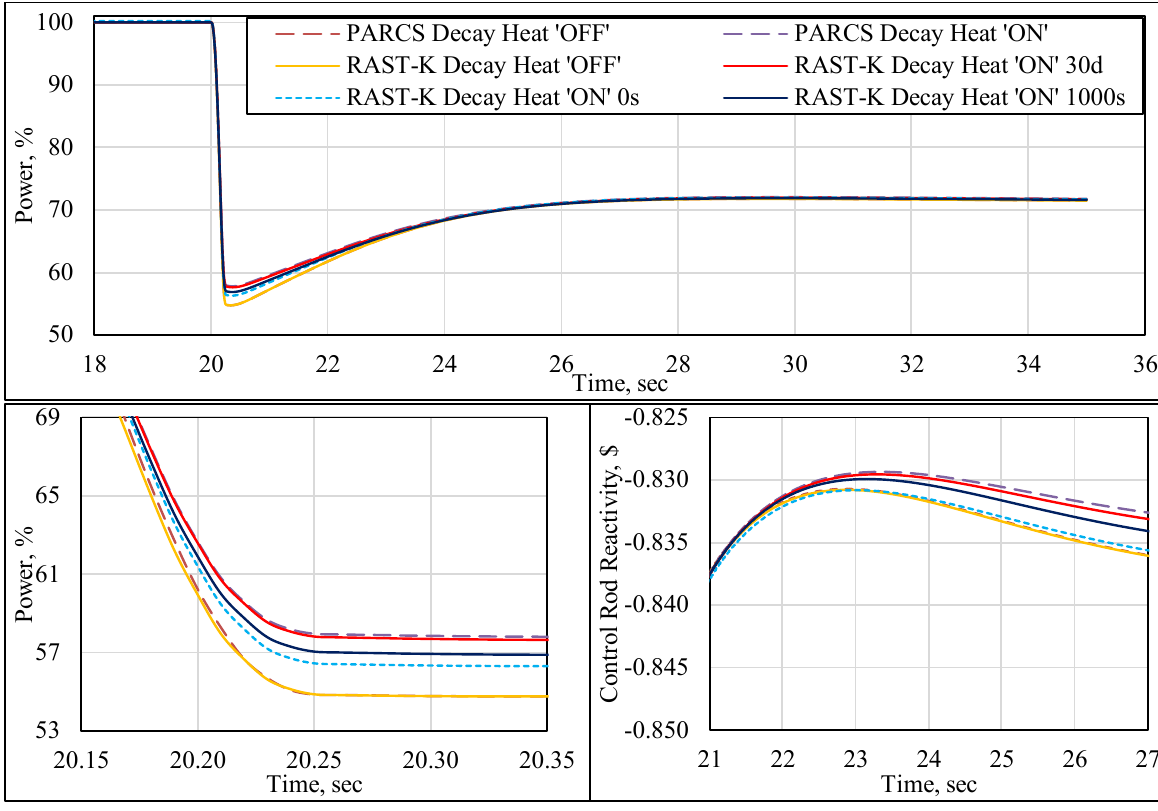
Figure 1. Power change for the full - power rod insertion scenario (bottom left - hand side – impact of DH on the value of power, bottom right - hand side - impact of DH on the CR